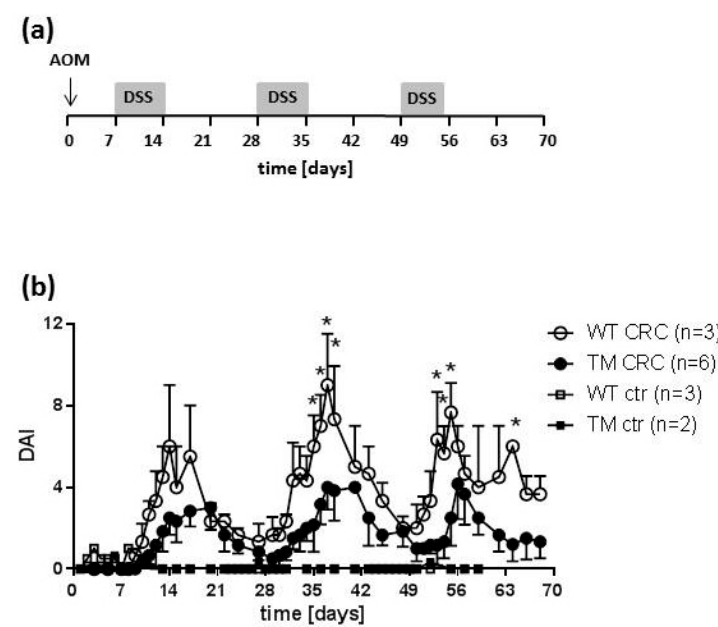
Figure 1. ( a ) Schematic representation of the schedule of acetoxymethan/dextran sulfate